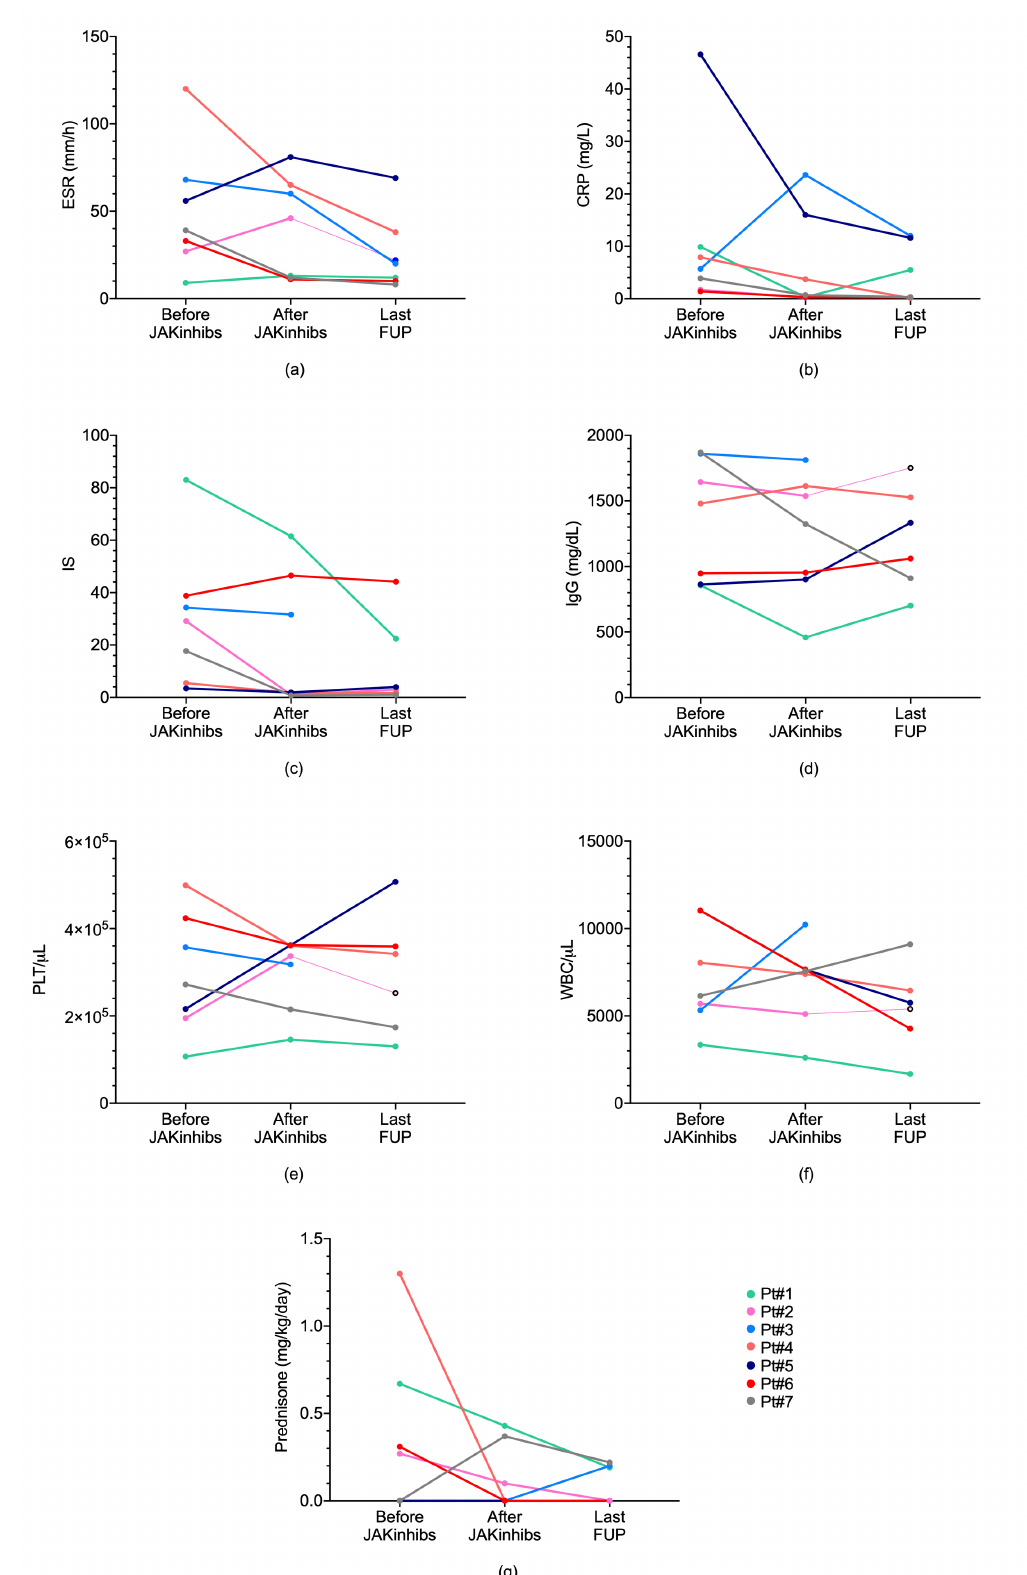
Figure 1. Laboratory findings and corticosteroid dosage before and after treatment with Janus kinase (JAK) inhibitors (JAKinhibs) in the seven subjects (pt 1–7). ( a ) ESR ( b ) CRP ( c ) IS ( d ) IgG ( e ) PLT ( f ) WBC ( g ) corticosteroid dosage. ESR, erythrocyte sedimentation rate; CRP, C-reactive protein; IS, interferon score; IgG, immunoglobulins; PLT, platelets; WBC, white blood count; pt,